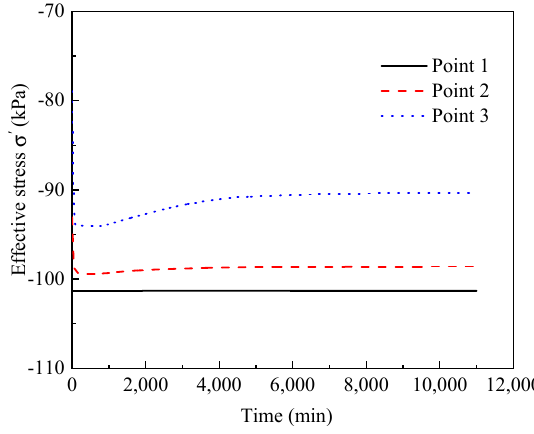
Figure 19. Evolution curves of vertical effective stress in saturated zone of railway subgrade.